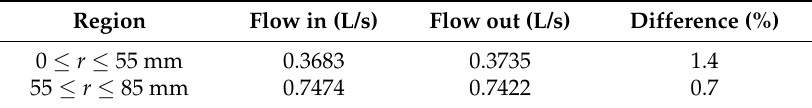
Table 1. Flow rate balance around the impeller at 300 rpm, − 20 ≤ z ≤ 20 (mm). Region Flow in